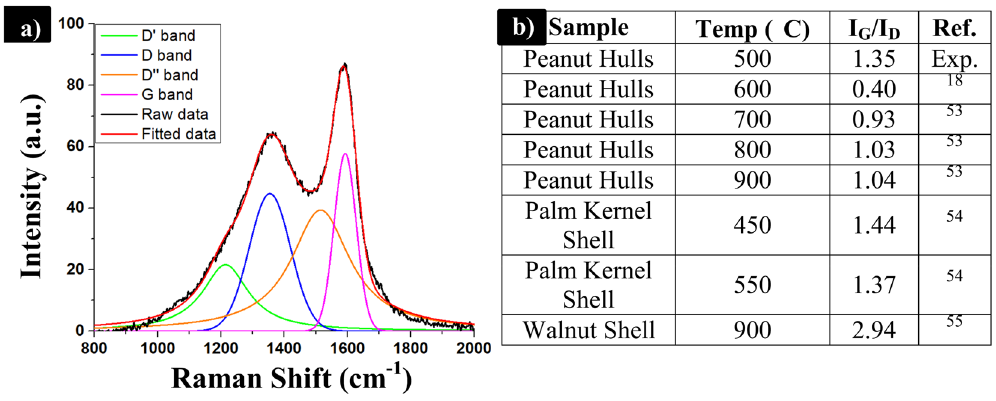
Figure 7. ( a ) Raman spectra for PH 500 °C biocarbon and ( b ) comparison of I G /I D ratios with other nut shells reported in